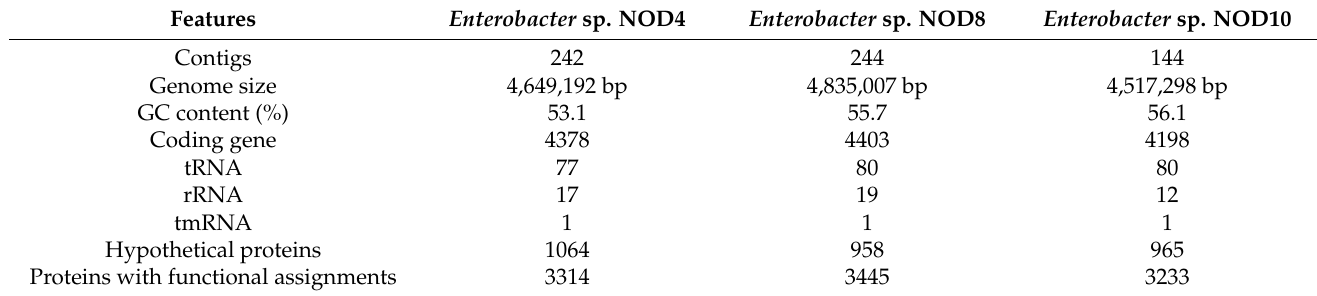
Table 1. Characteristics of the genomes of Enterobacter endophytic strains.